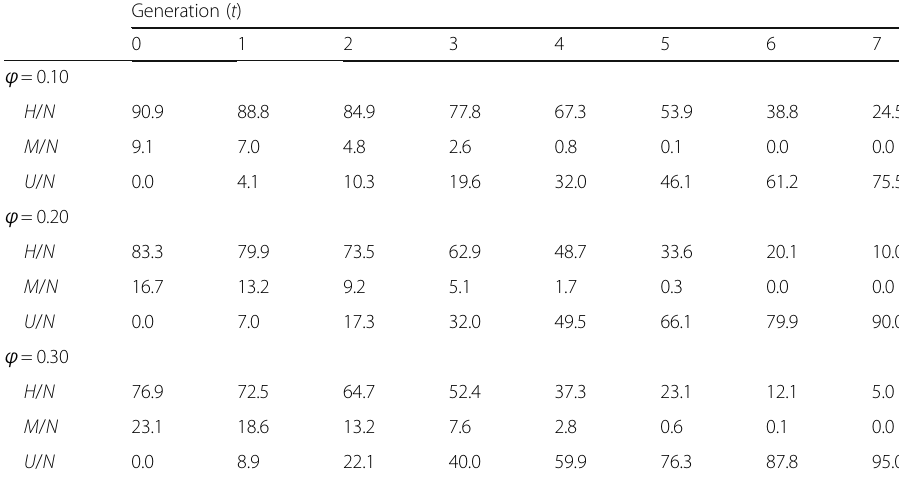
Table 4 Component populations as percent of total: indifference preference pattern with one-time immigration ( ϕ = 0.10, 0.20,